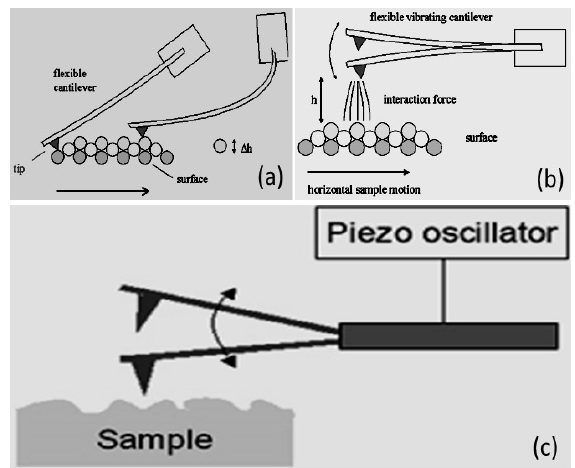
Figure 1. Di ff erent modes of scanning in an AFM: ( a ) contact mode; ( b ) non-contact mode, and ( c ) Figure 1. Different modes of scanning in an AFM: a ) contact mode; b ) non-contact mode, and c ) tapping mode. The figure is designed by the authors